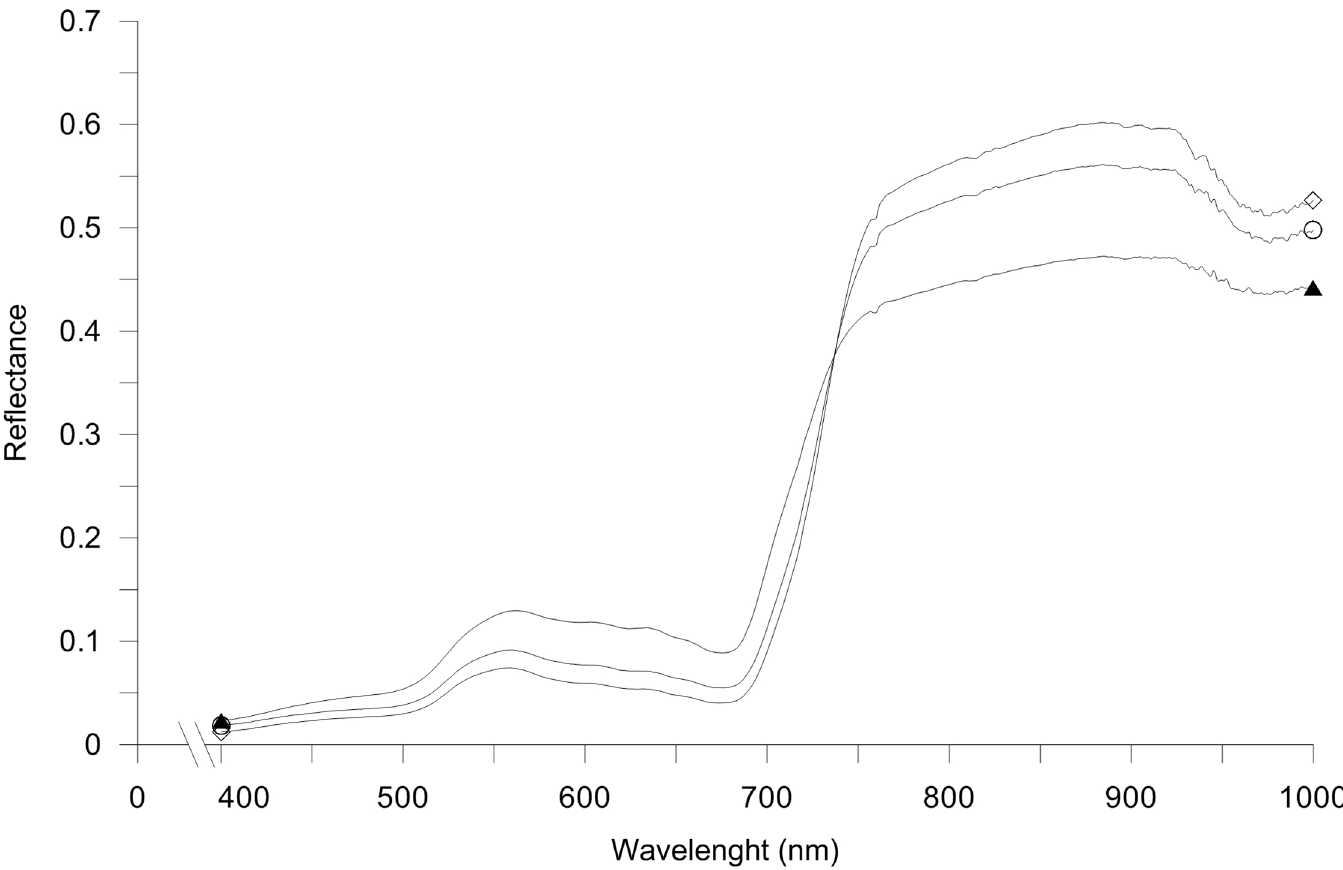
Fig 6. Canopy reflectance of durum wheat plants (averaged over DC65, DC71, DC75 and DC77 phenological stages). Durum wheat plants were exposed to control conditions (unfertilized CONTROL, black triangle) and to N fertilization treatments with urea (UREA, white rhombus) and calcium nitrate (NITRATE, white circle) at the rate of 150 kg N ha -1 , in